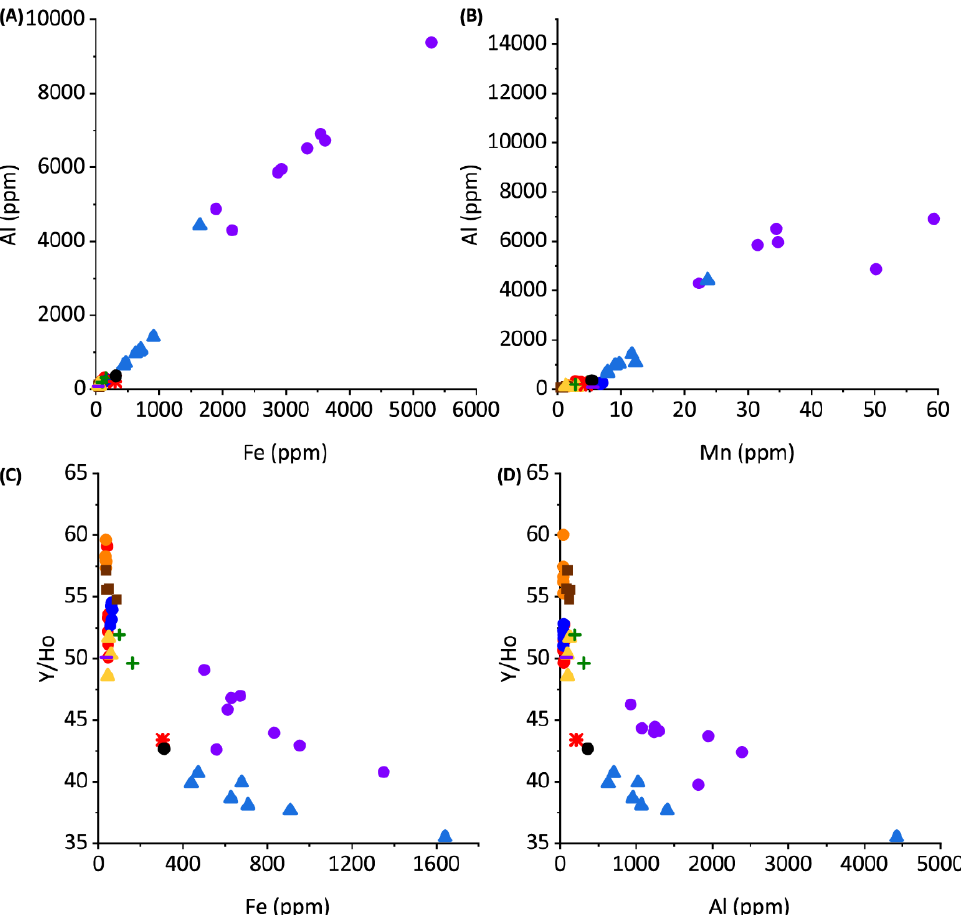
Figure 5. Proxies for terrestrial and siliciclastic contribution to rare earth geochemistry of sediments.